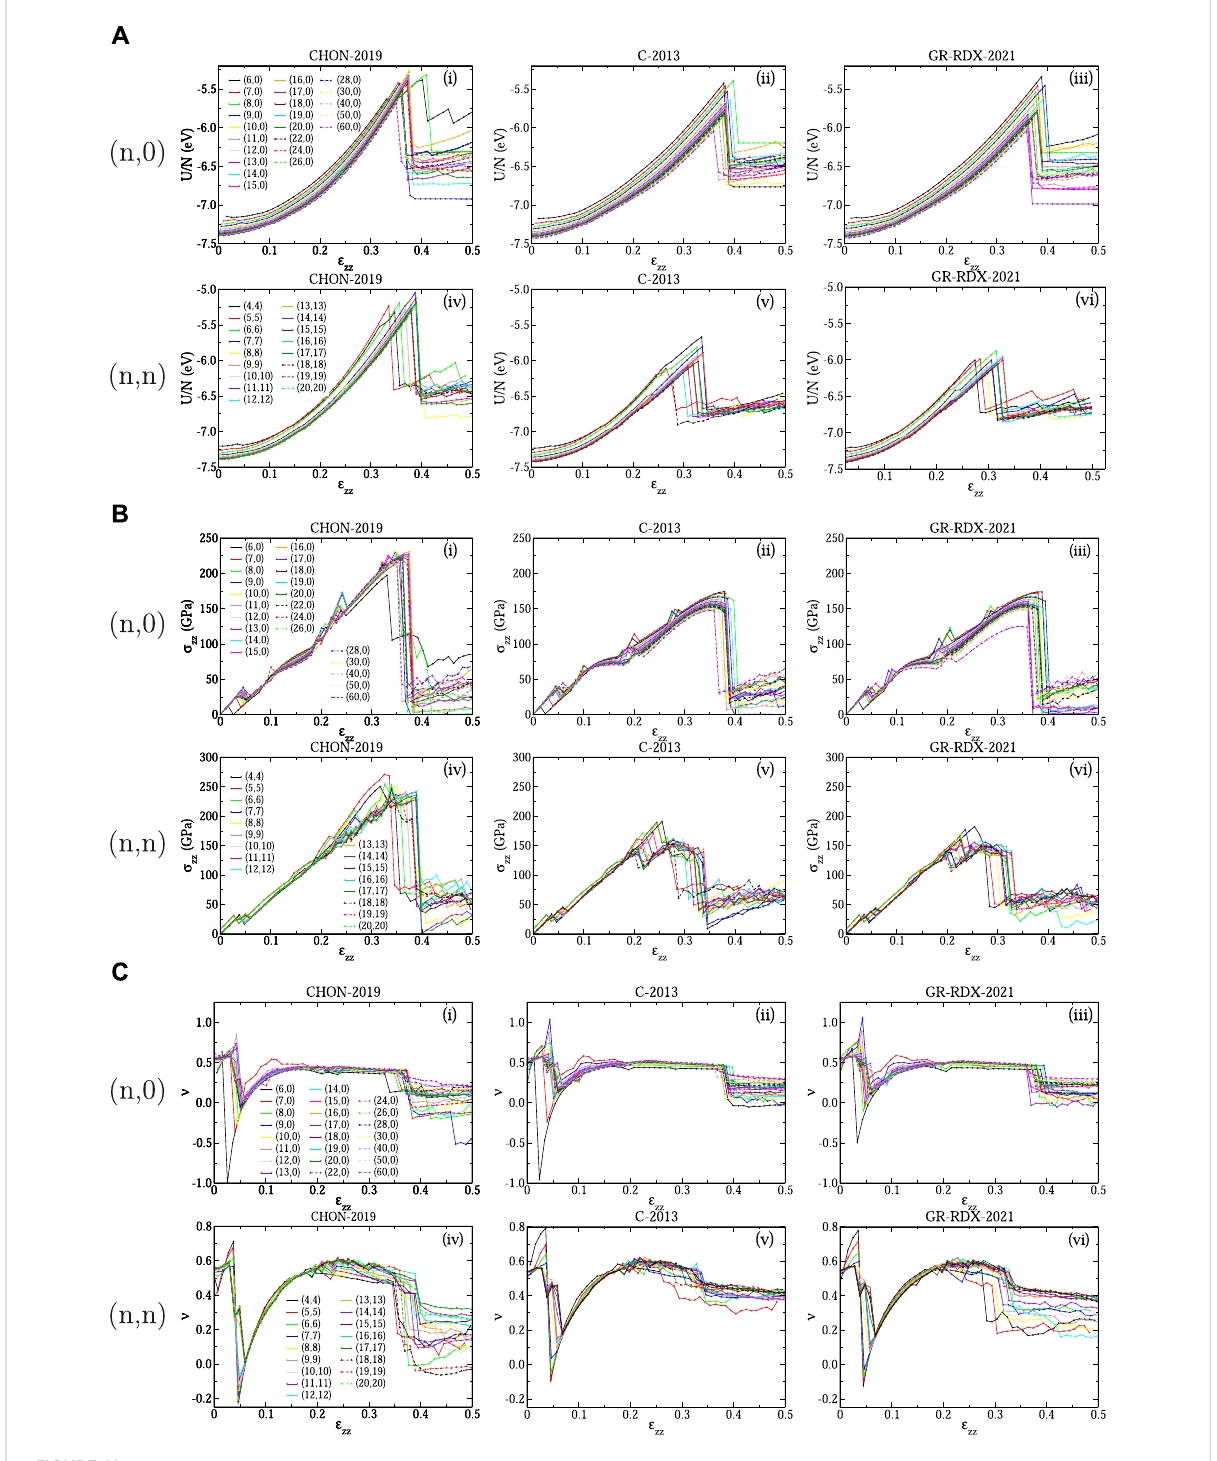
FIGURE 11 Response of CNTs to strain: (A) Energy per atom U / N , (B) stress σ zz and (C) Poisson ’ s ratio ] as a function of strain ε zz for ( n , 0) (subpanels i, ii, iii) and ( n , n ) (subpanels iv, v, vi) CNTs predicted using the CHON-2019 (subpanels i, iv), C-2013 (subpanels ii, v) and GR-RDX-2021 (subpanels iii, vi)